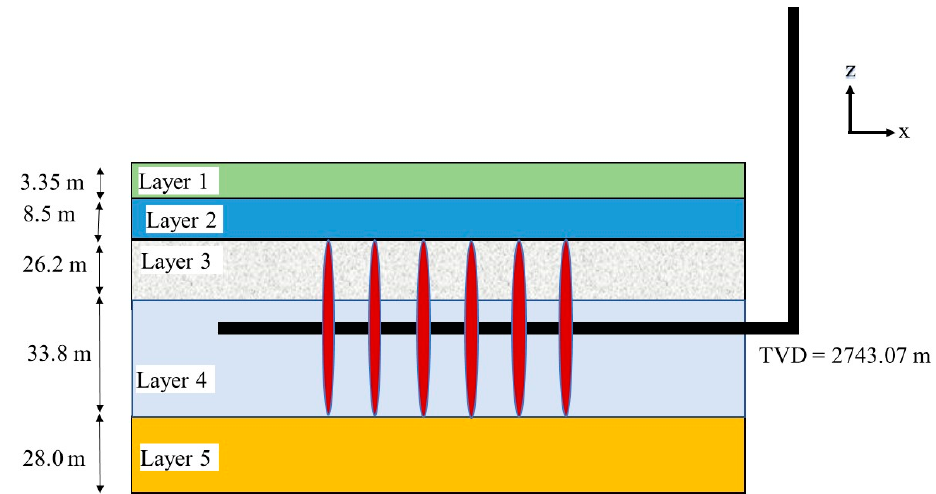
Figure 6. A vertical cross-section of the reservoir rock layers. The parent well fractures are assumed to be fully contained in Layers 3 and